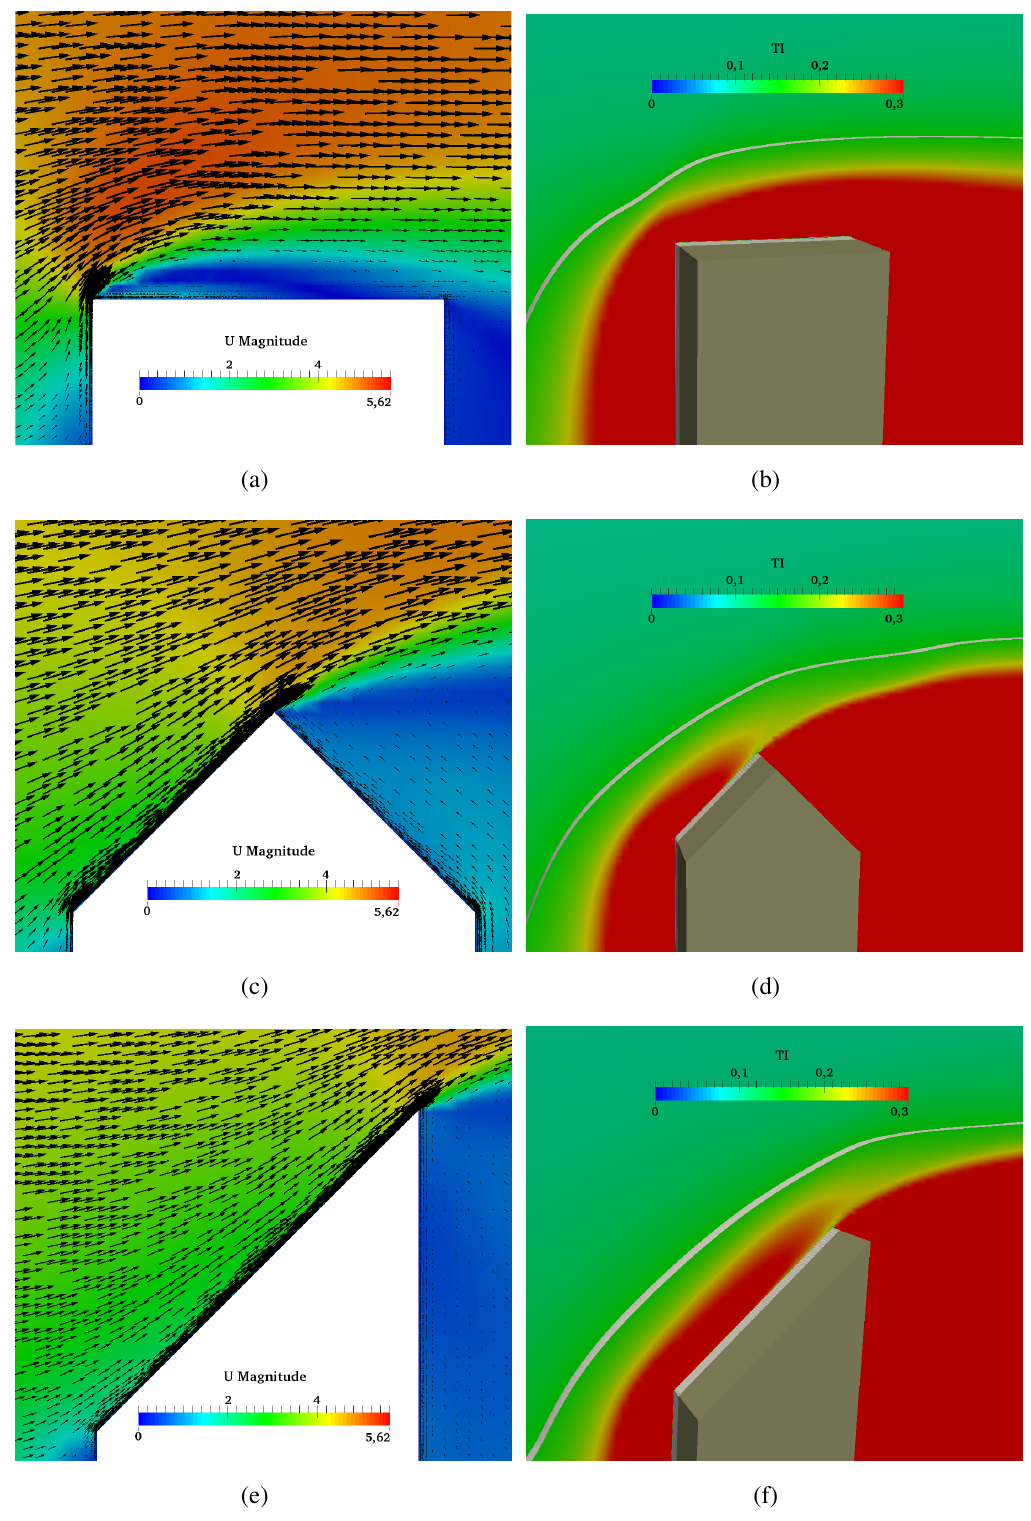
Figure 12. Comparison of U and T I fields on the roof for the state-of-the-art cases: sharp roofs. ( a ) U field flat roof; ( b ) T I field flat roof; ( c ) U field pitched roof; ( d ) T I field pitched roof; ( e ) U field shed roof; ( f ) T I field shed